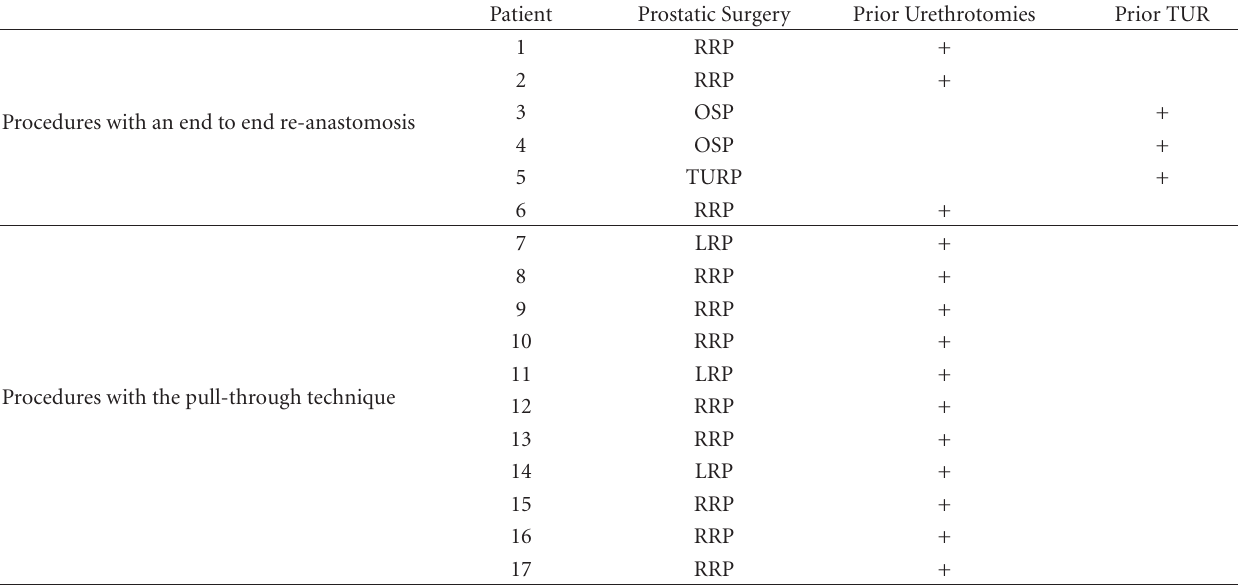
Table 1: Pre-operative patients